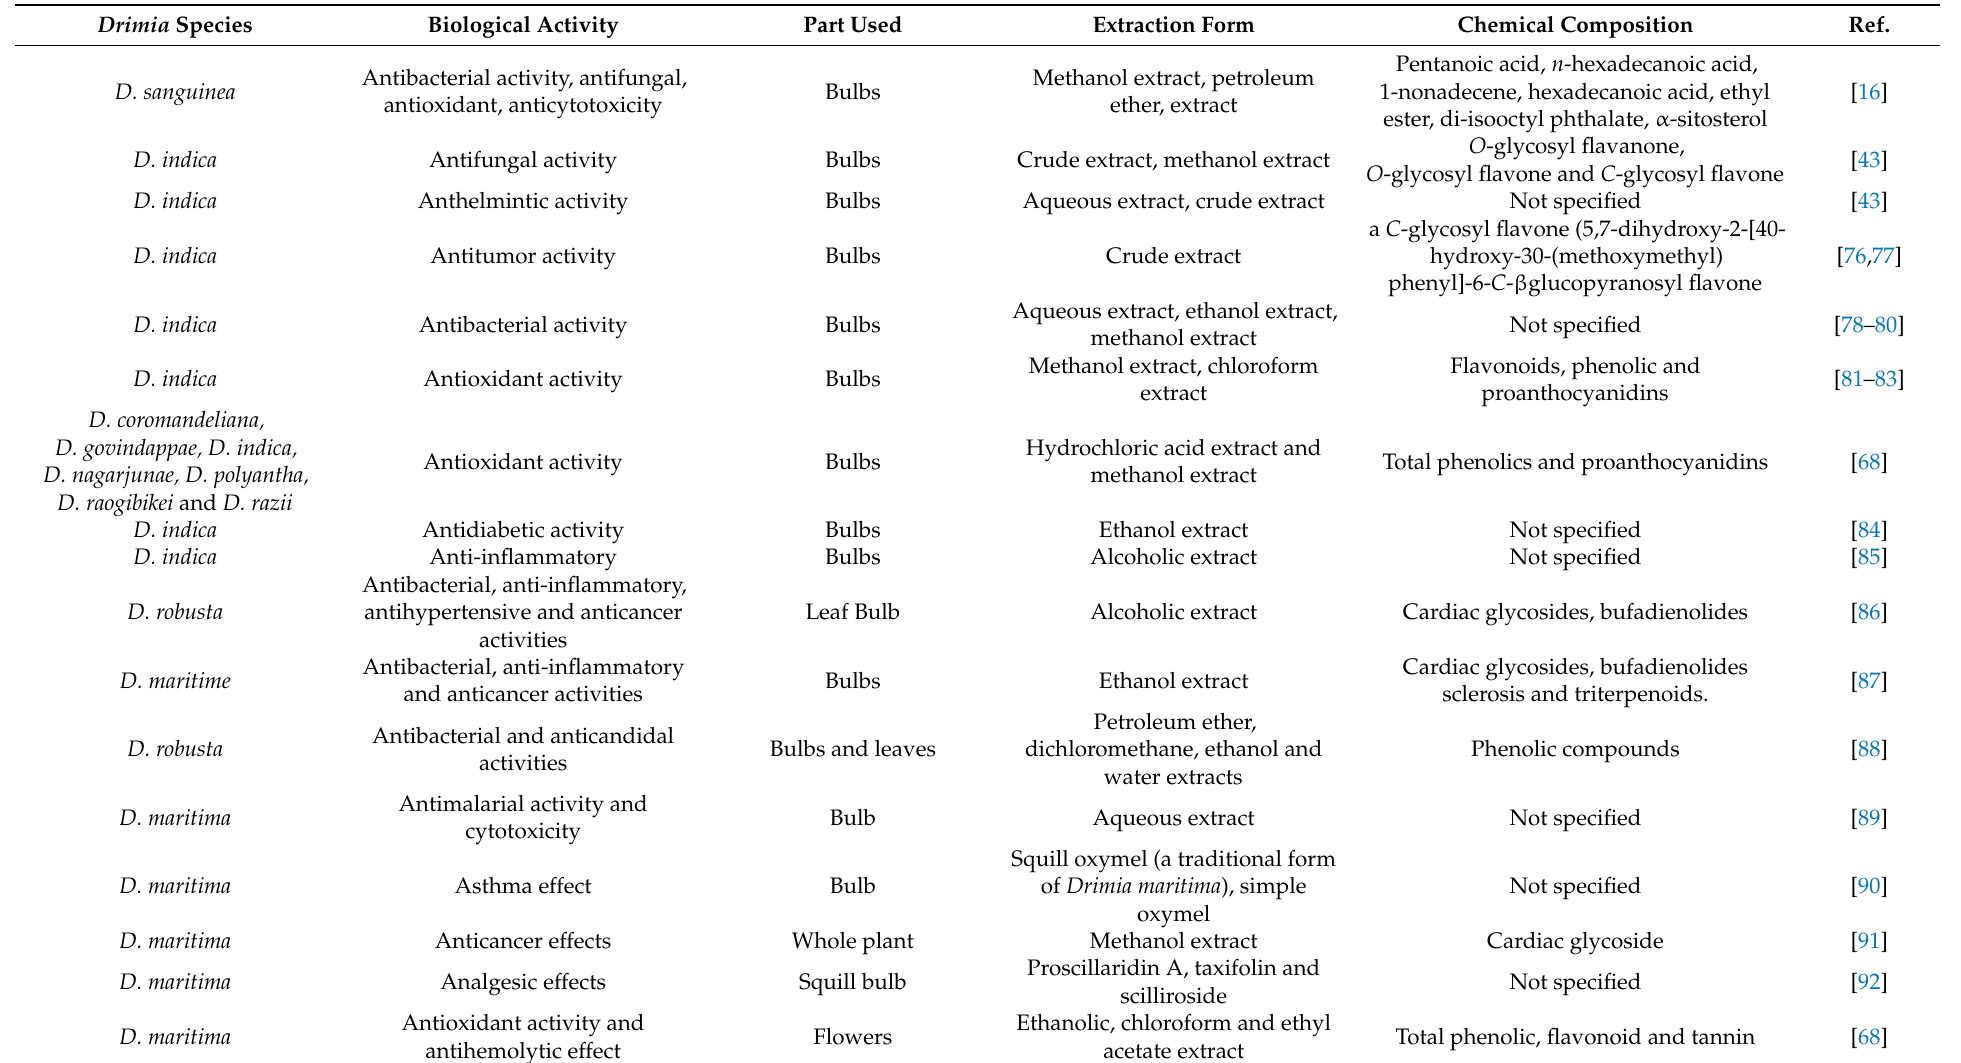
Table 1. Biological investigation of Drimia